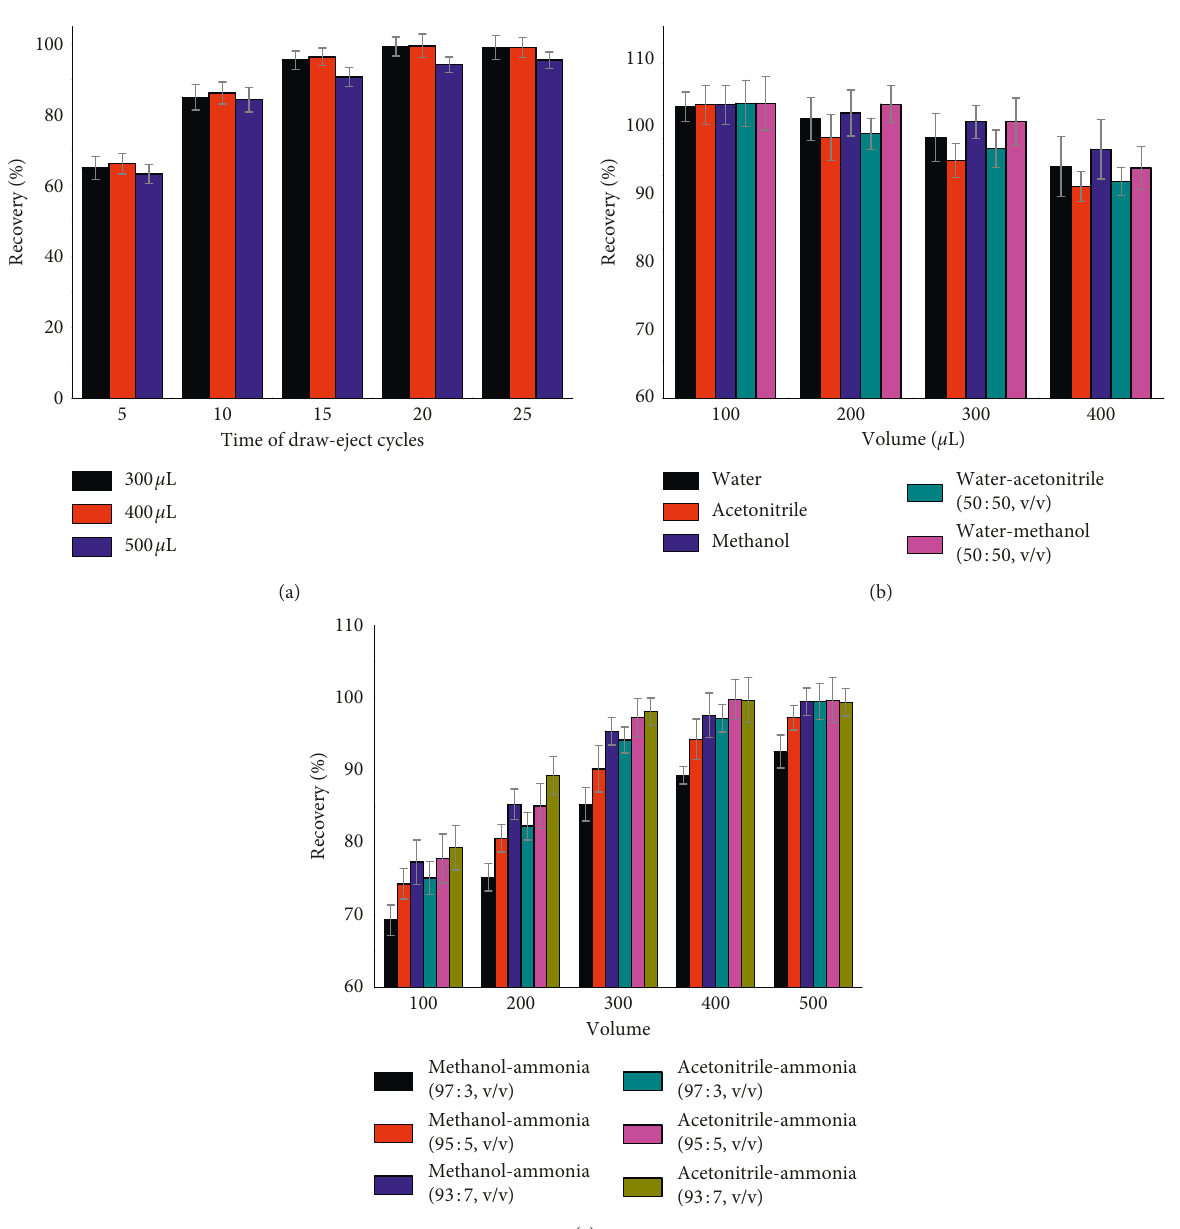
Figure 6: Effect of sample volume and draw-eject cycles (a) washing solution (b), and eluent solution (c) on the recovery of